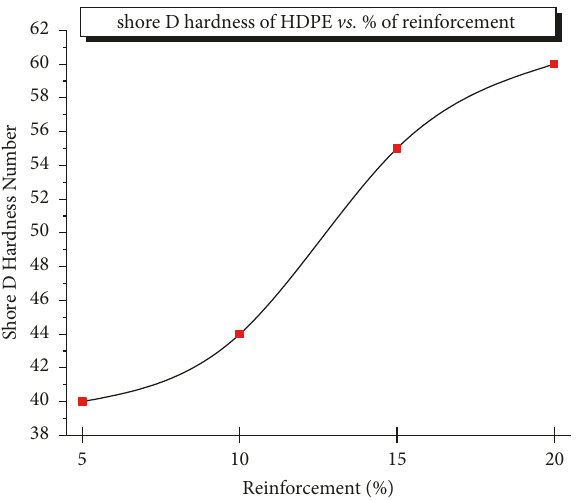
Figure 5: Variation of hardness with % reinforcement.